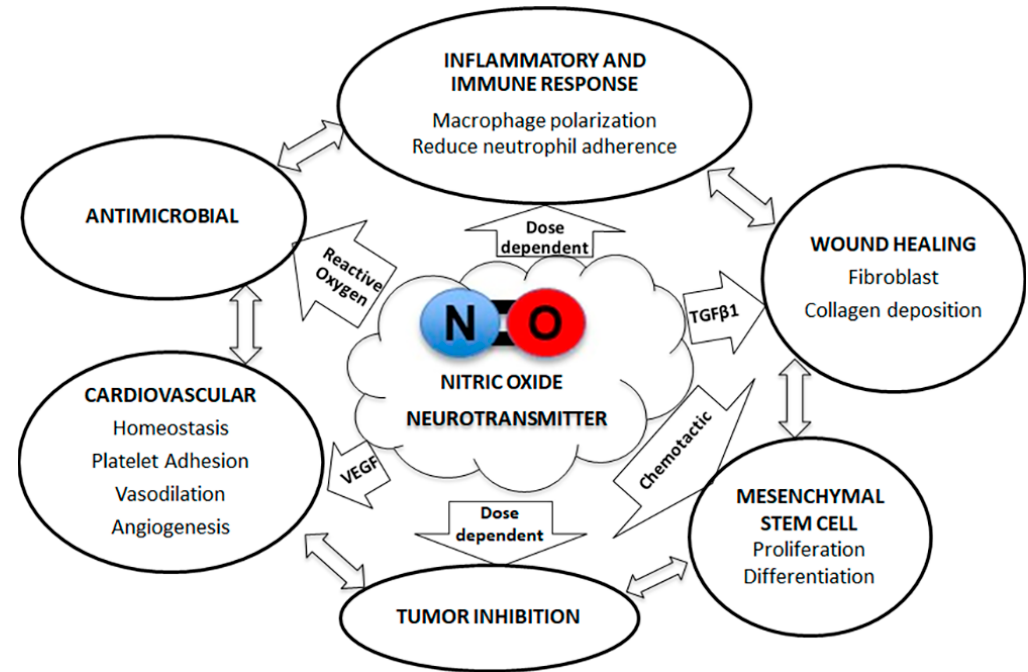
Figure 2. Multifunctional effects of nitric oxide for potential tissue regeneration.